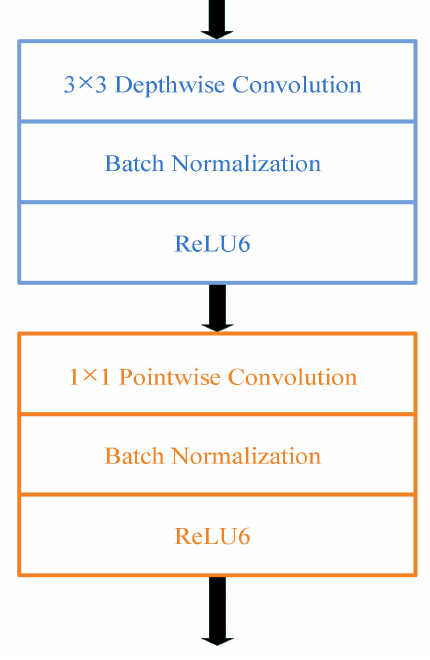
Figure 7. MobileNet